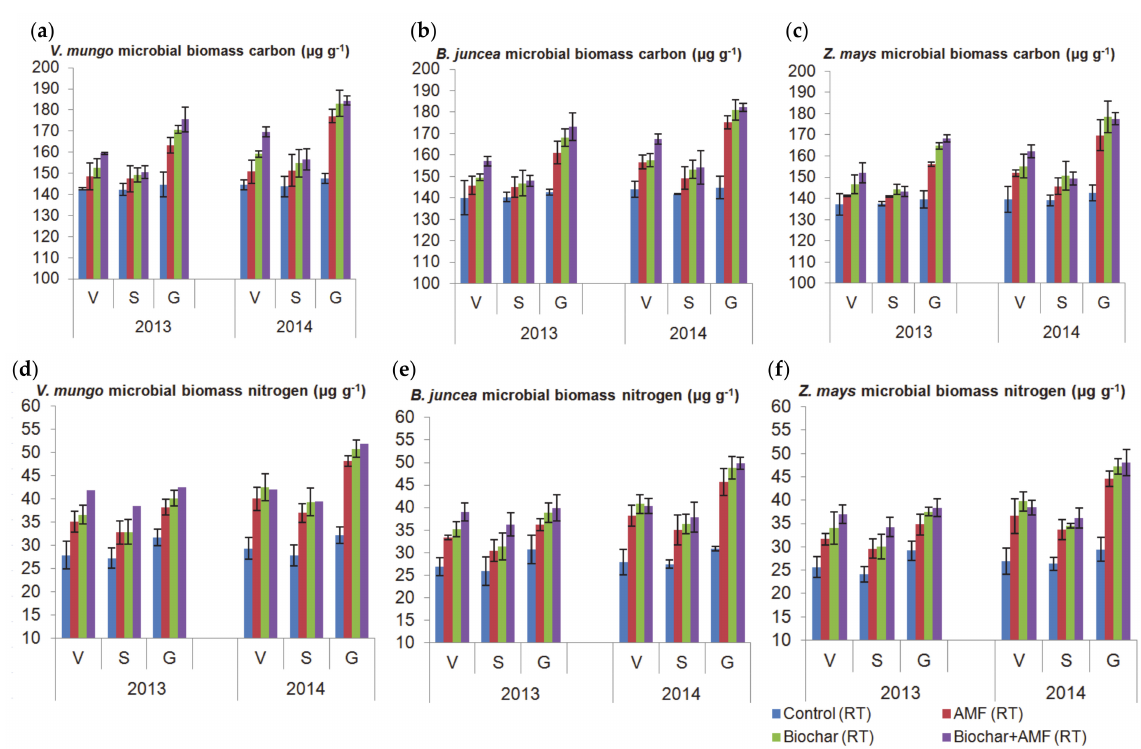
Figure 2. Soil microbial biomass carbon (MBC) and microbial biomass nitrogen (MBN) results showing significant increases under integrated SAI-managed fields in comparison to control at the three experimental sites (ES1-Varanasi (V), ES2- Sultanpur (S) and ES3-Gorakhpur (G)) for three crops, i.e., MBC ( a – c ) and MBN ( d – f ) for V. mungo, B. juncea, and Z. mays, respectively. A total of four given treatments included one control (RT), i.e., reduced tillage with no biochar and AMF amendments; and three SAIs, i.e., AMF + RT (arbuscular mycorrhizal fungi amendment with reduced tillage), biochar + RT (biochar amendment with RT), and AMF + biochar + RT (integration of all aforementioned SAIs). Data values represent mean ± SD of different treatments ( n =18) with significant difference ( p =